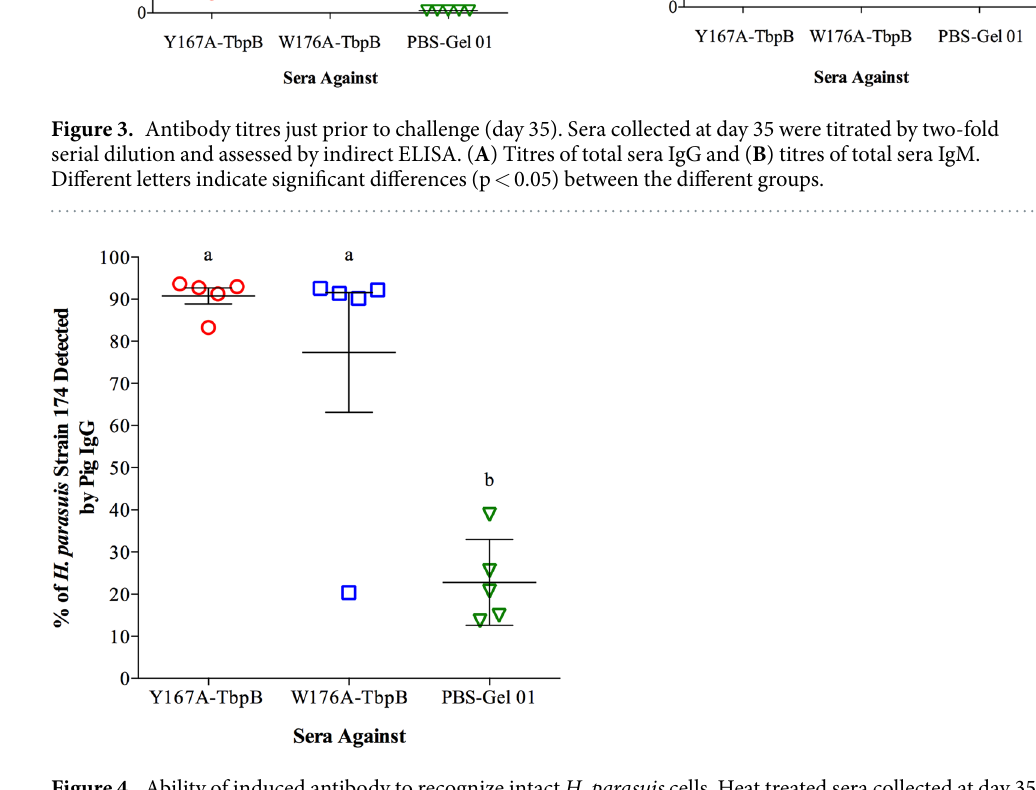
Figure 4. Ability of induced antibody to recognize intact H. parasuis cells. Heat treated sera collected at day 35 were incubated with live H. parasuis strain 174 (SV7) and analysed by flow cytometry. Different letters indicate significant differences (p < 0.05) between the different